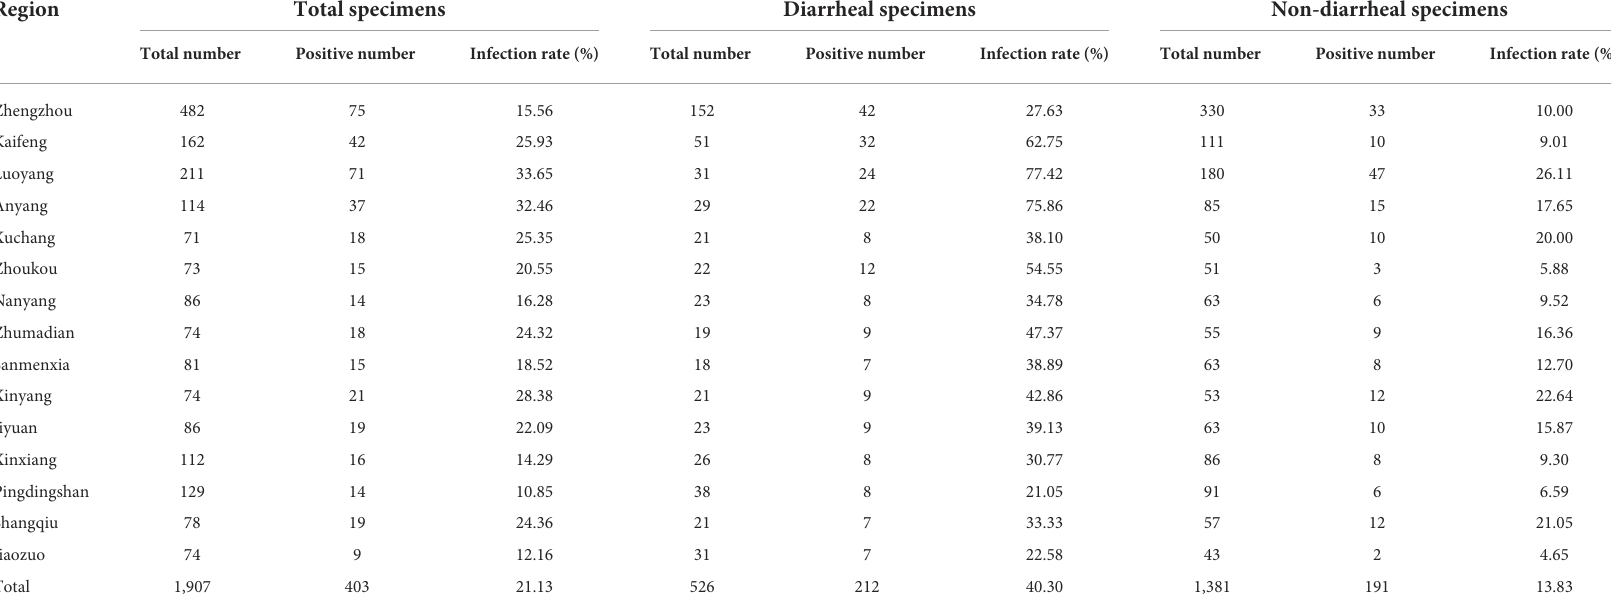
TABLE 2 CEV/OEV infection in different regions in Henan Province. Region Total specimens Diarrheal